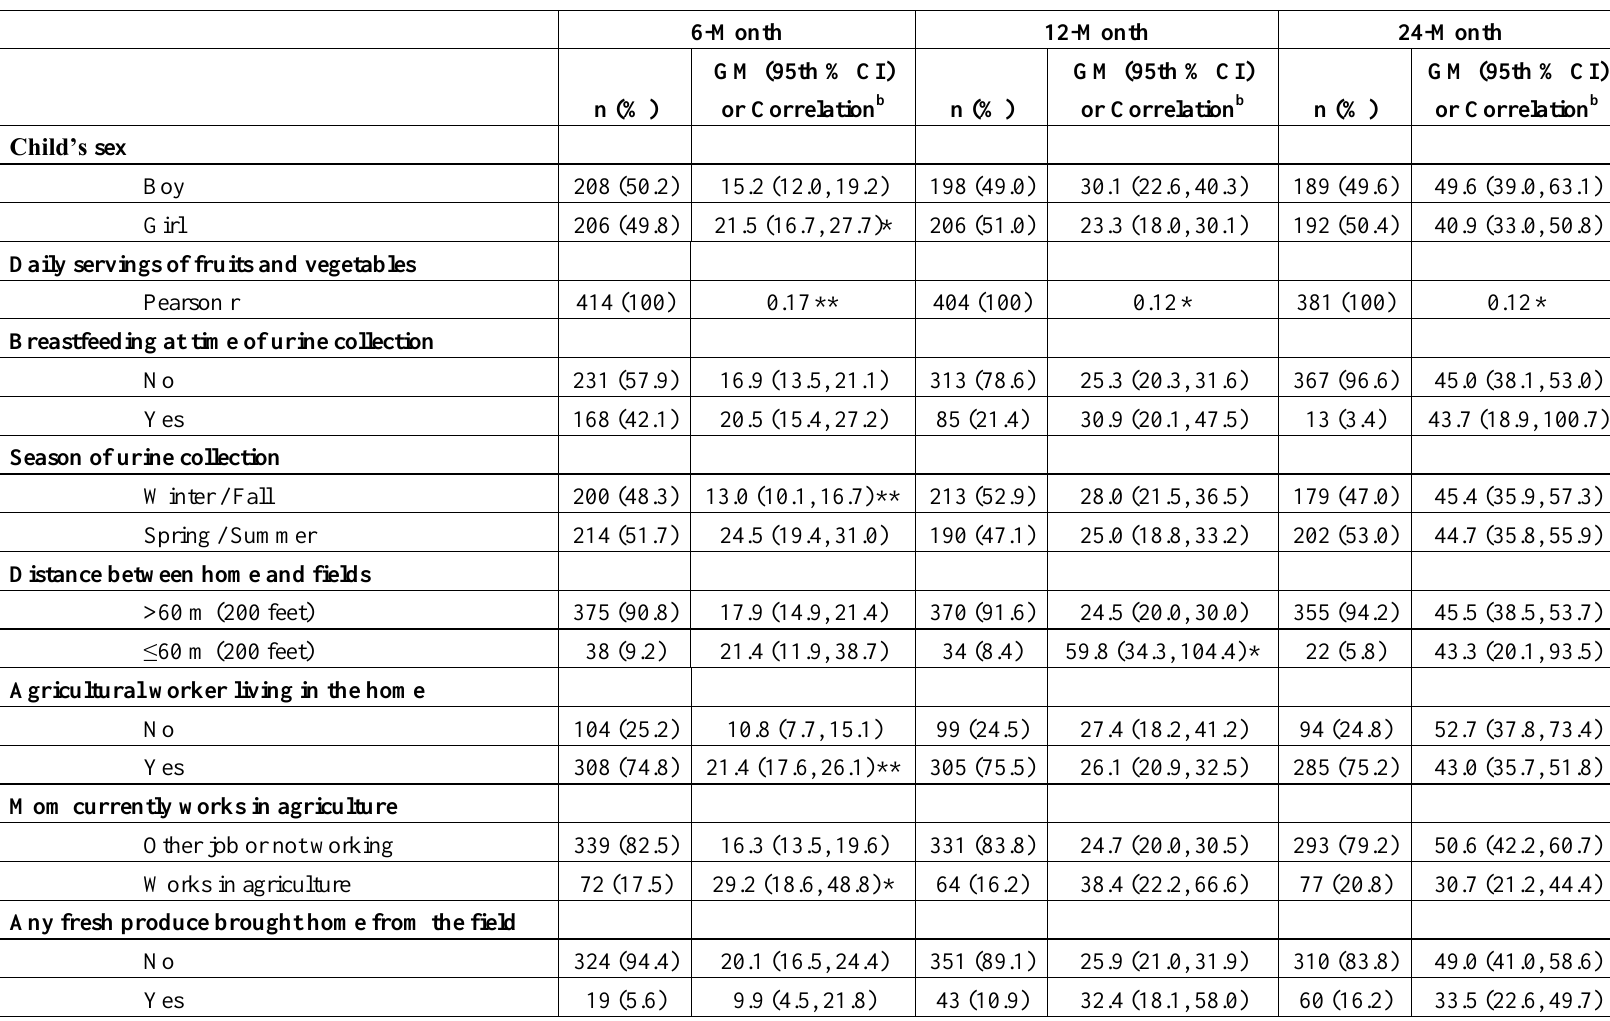
Table S3. Summary of children’s geometric mean DMAP urinary metabolite levels (nmol/L) and exposure prediction factors a